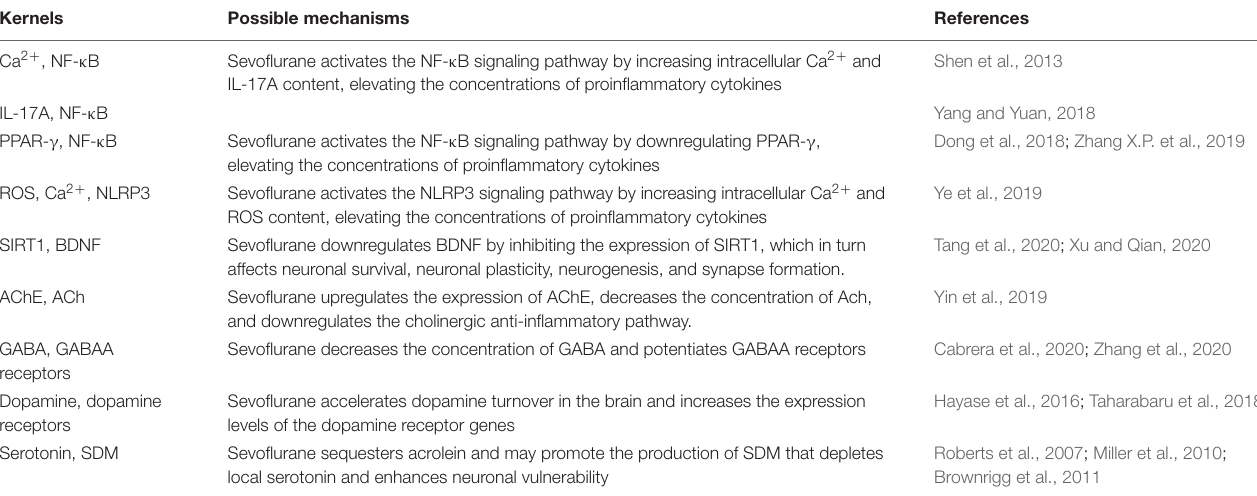
TABLE 3 | Possible mechanisms of sevoflurane-induced postoperative cognitive dysfunction. Kernels